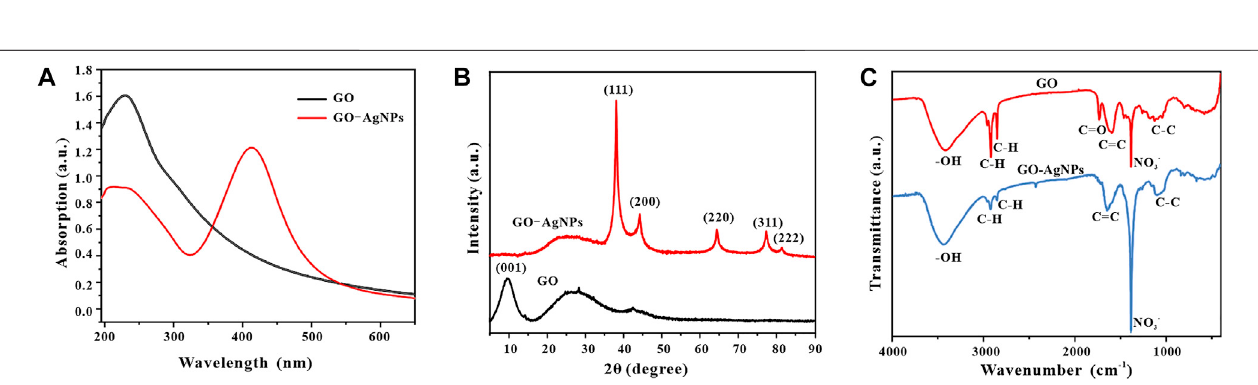
FIGURE 7 | Uv-vis spectra (A) , XRD patterns (B) and FT-IR spectra (C) of GO and GO-AgNPs synthesized under optimal conditions.